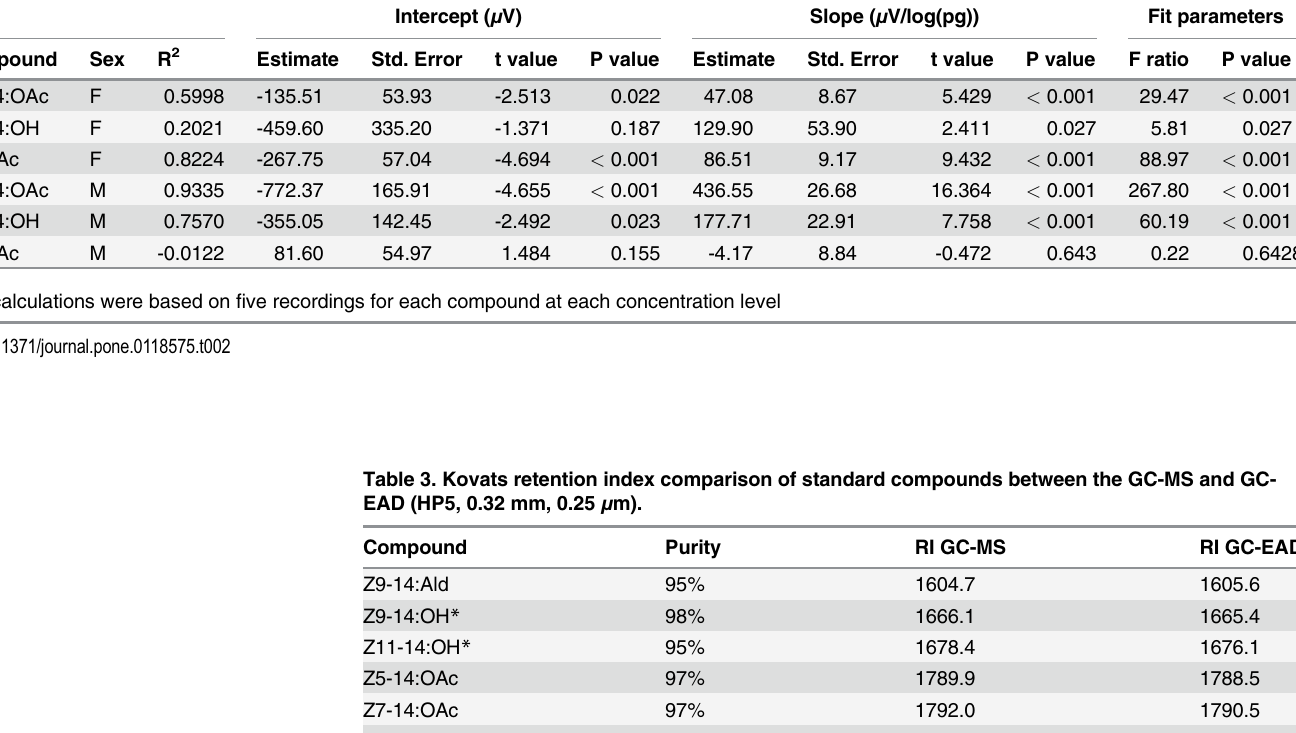
Table 2. Linear fi t to dose response curve parameters for EAD data for C. tristis males and females. Intercept ( μ V) Slope ( μ V/log(pg)) Fit parameters